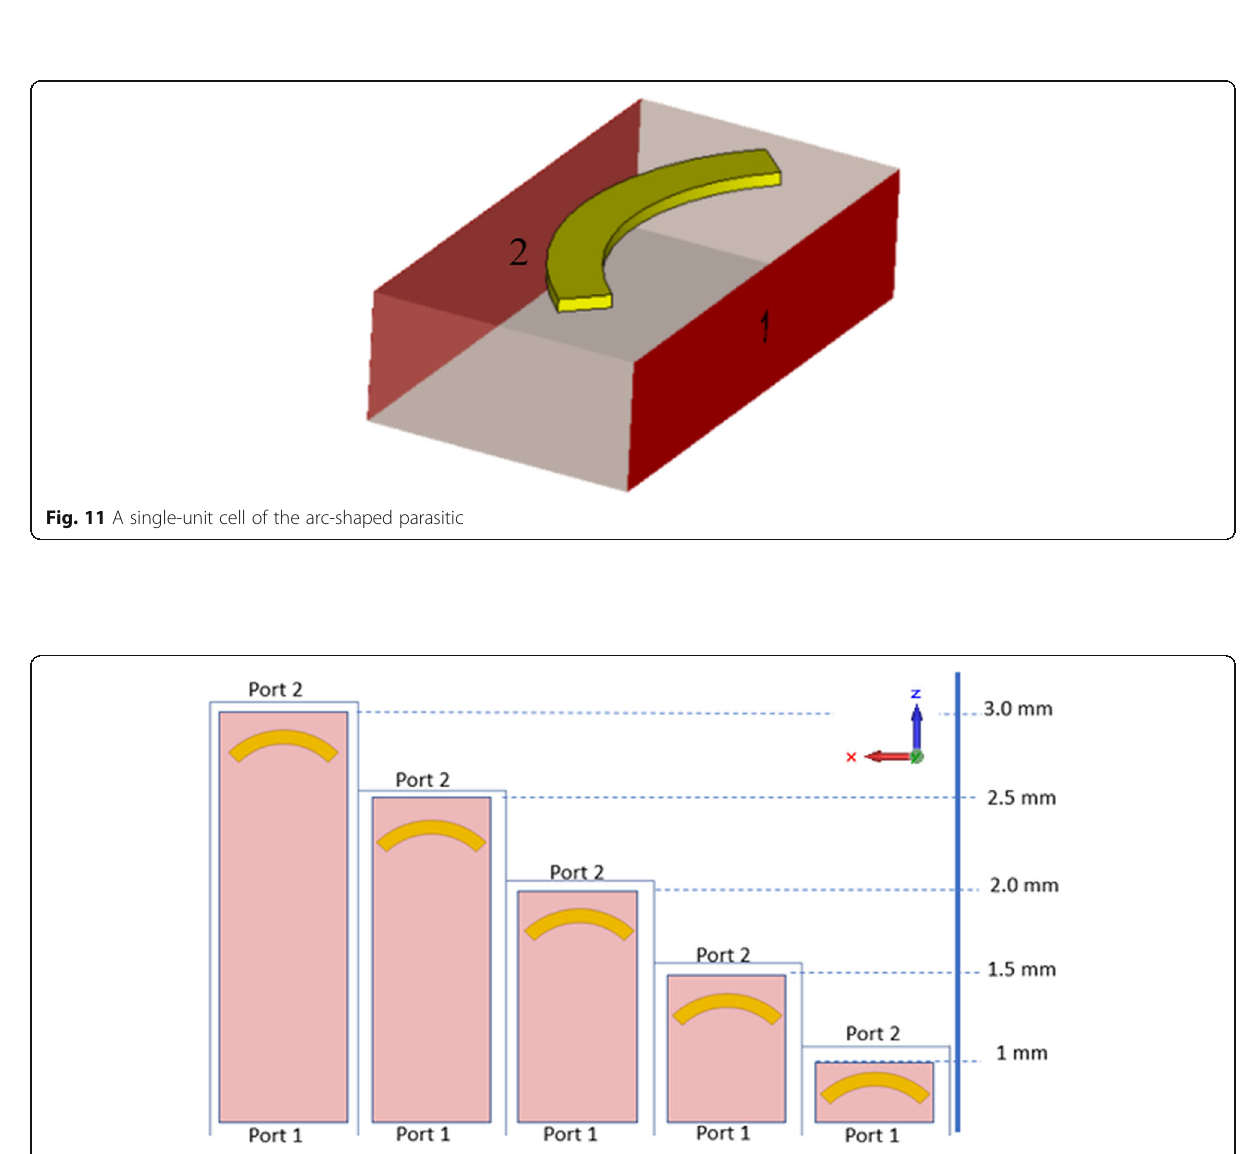
Fig. 12 Illustration depicting the way of refractive index